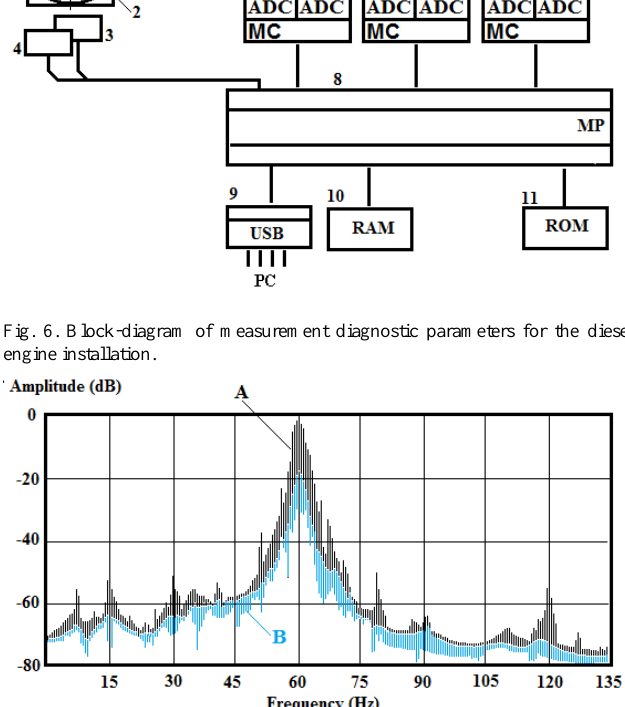
Fig. 7. Frequency spectrum of the stator current of the generator. A-spectrum of the diesel –generator with disturbances of the cylinder-piston group param- eters; B-spectrum is a standard of the diesel-generator